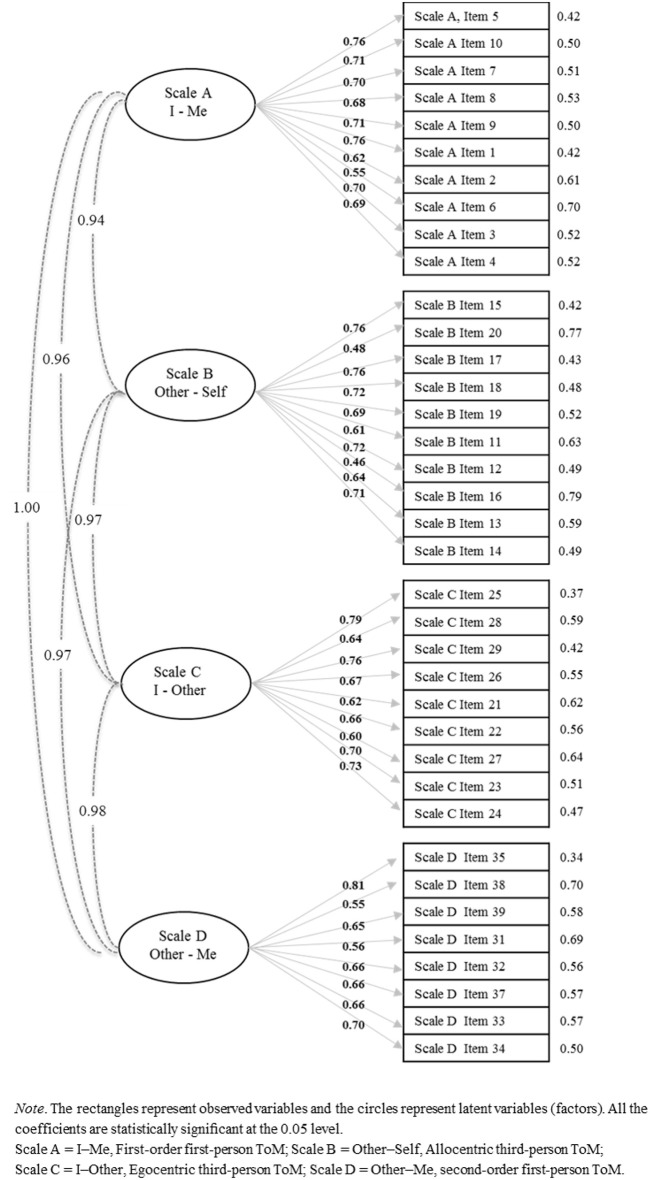
Standardized solution of the four-factors CFA model of Th.o.m.a.s. (N = 154).